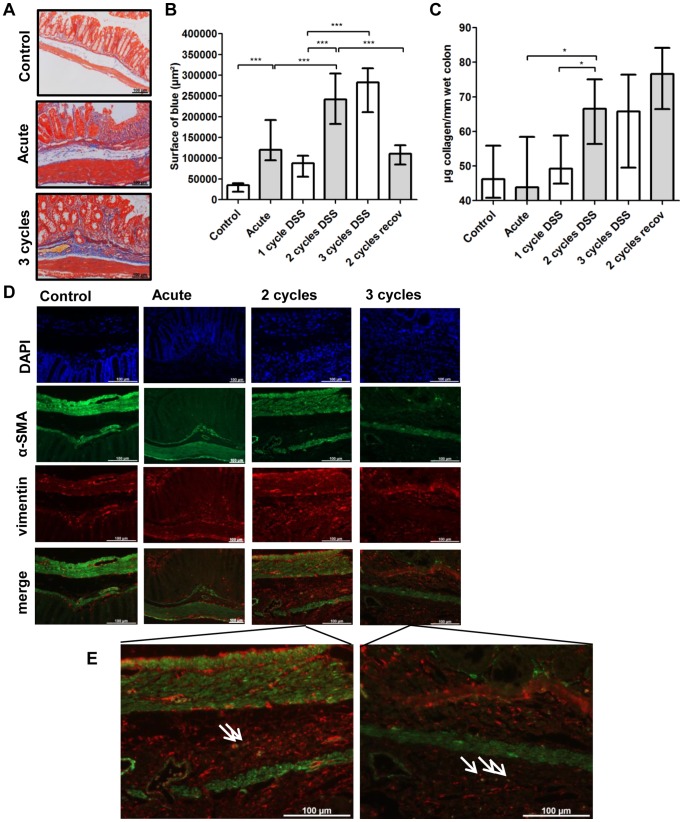
Fibrogenic changes in the colon.(A) Representative pictures of an Martius-scarlet-blue (MSB) staining of control mice, acute colitis and 3-cycles mice. A clear deposition of collagen in the submucosa is present in chronic DSS colitis. (B) Histological scoring of fibrosis using a MSB-staining shows that more cycles of DSS are associated with more fibrosis (surface of blue in mucosa and submucosa). More recovery is associated with a lower degree of fibrosis. (C) Hydroxyprolin assay. Data are expressed as µg collagen per mm wet colon. Data are expressed as medians with IQR. Mann-Whitney U testing (*p<0.05, **p≤0.01, ***p≤0.001). (D-E) Analysis of the mesenchymal cells in the submucosa shows the presence of myofibroblasts (α-SMA+ and vimentin+) in the submucosa after 2 and 3 cycles, indicated with the arrows. These cells are absent in control colon and in acute colitis.